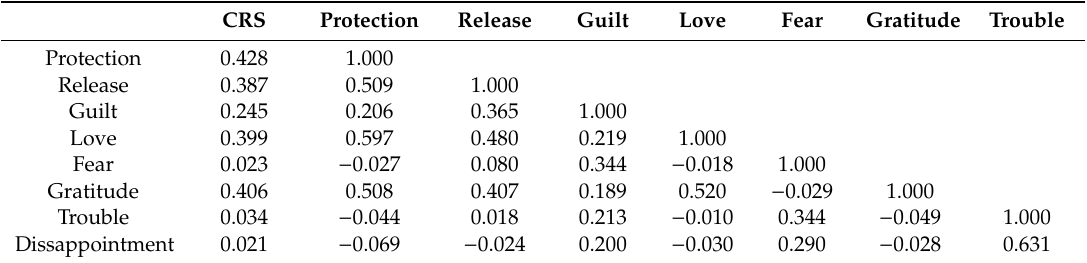
Table 5. Correlation Matrix CRS and Emotions towards God (EtG).